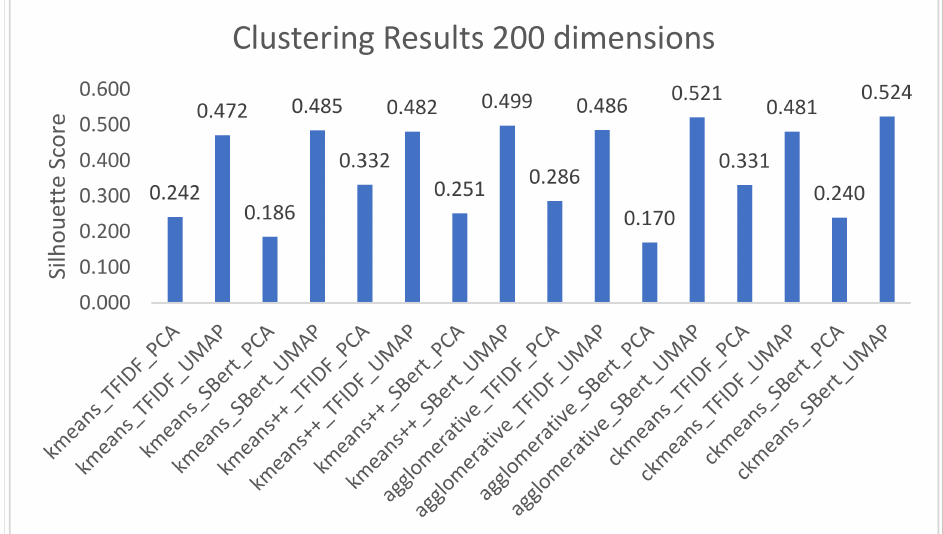
Figure 4. Clustering results with every approach at the 200 dimensions on the baseball dataset.